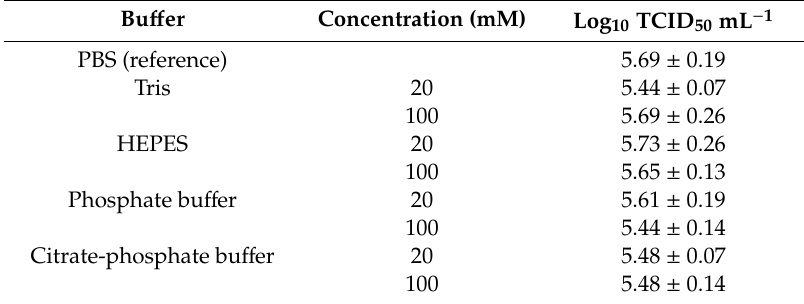
Table 2. Influence of di ff erent bu ff ers (pH 7.4) at two di ff erent concentrations on the infectivity of MV. Data are means plus standard deviations of triplicate.